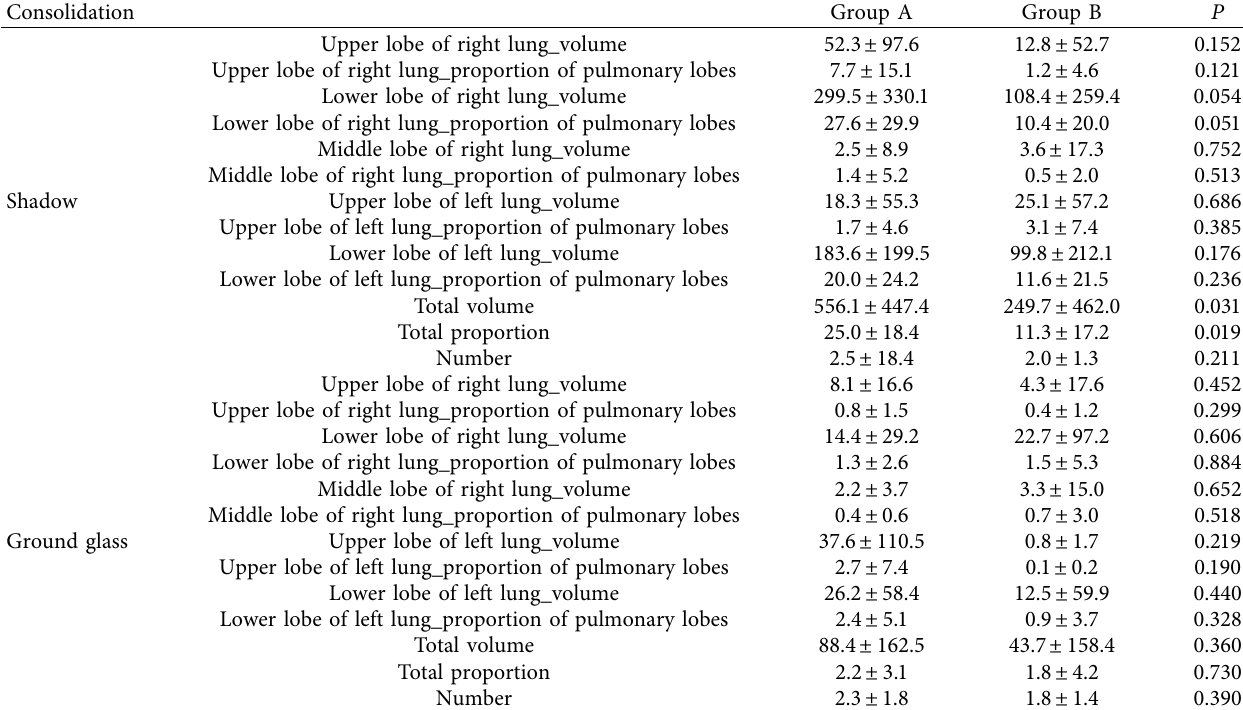
Table 2: Comparison of imaging features between group A and group